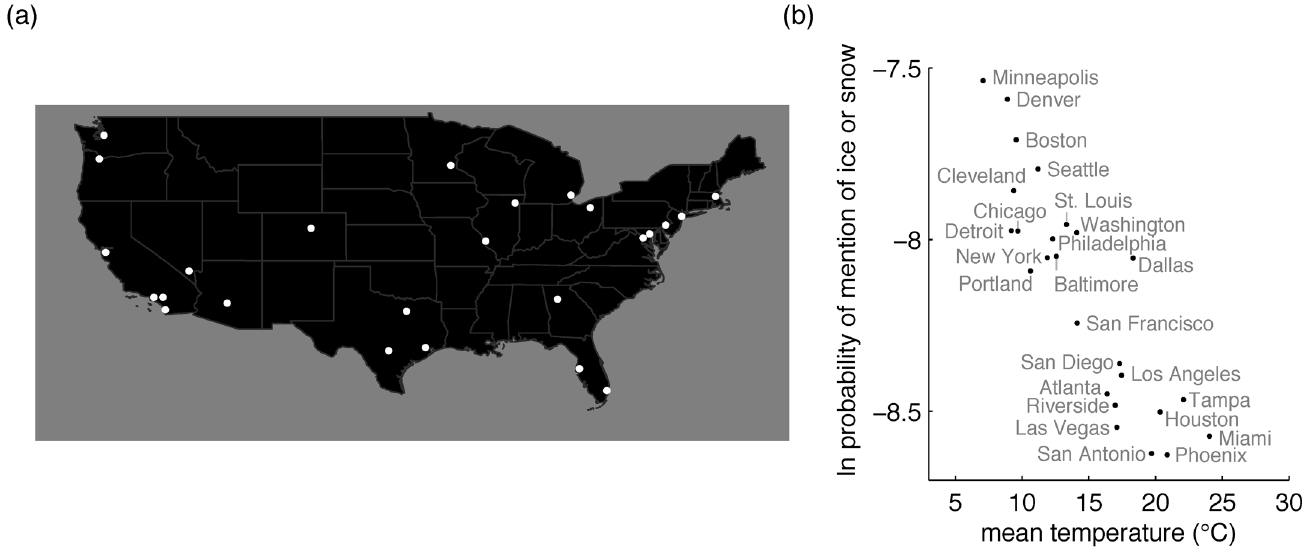
Fig 4. Results of US Twitter analysis. (a) Locations associated with the 25 urban areas represented in the Twitter analysis of American English. (b) Natural log probability of mention of ice or snow in a given urban area as a function of the mean temperature in that area. Logistic regression revealed that temperature is negatively associated with probability of mention of ice or snow ( β = − 0.060, χ 2 (1) = 322, p < 10 − 15